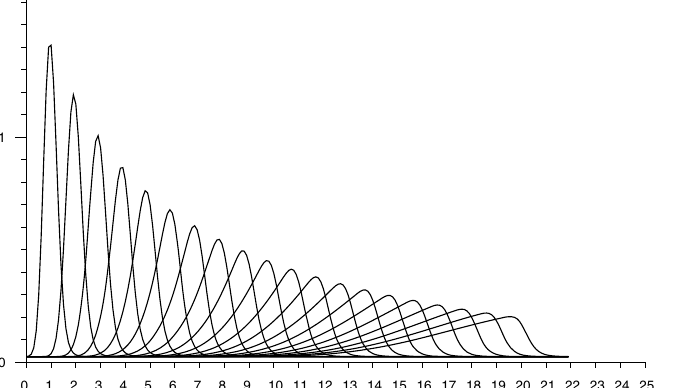
Figure 10. Rate vectors used in updating the Bayesian grid (horizontal axis actual distance—meters) taking into account measurement error with st. dev. of 0.25 m. Each curve corresponds to a different value for the reported distance. Curves shown for reported distance of 1 m, 2 m, . . ., 20